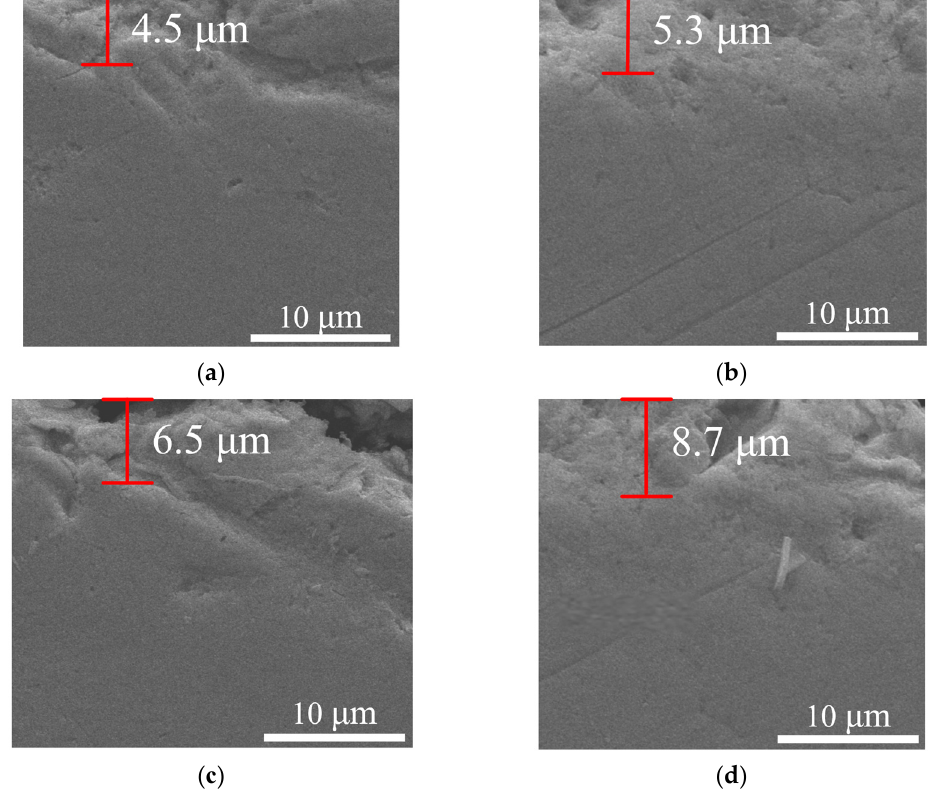
Figure 14. In fl uence of fl ank wear on metamorphic layer thickness under high-pressure cooling: ( a ) Figure 14. Influence of flank wear on metamorphic layer thickness under high-pressure cooling: VB = 0 mm; ( b ) VB = 0.1 mm; ( c ) VB = 0.2 mm; ( d ) VB = 0.3 mm. ( a ) VB = 0 mm; ( b ) VB = 0.1 mm; ( c ) VB = 0.2 mm; ( d ) VB = 0.3